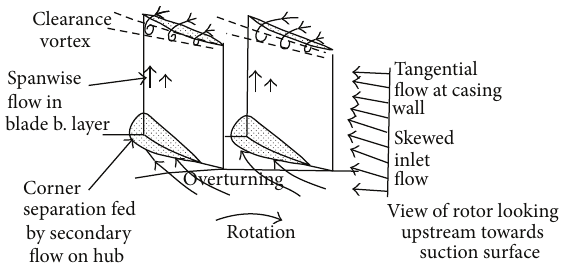
Figure 1: Typical flow structures inside a compressor blade passage